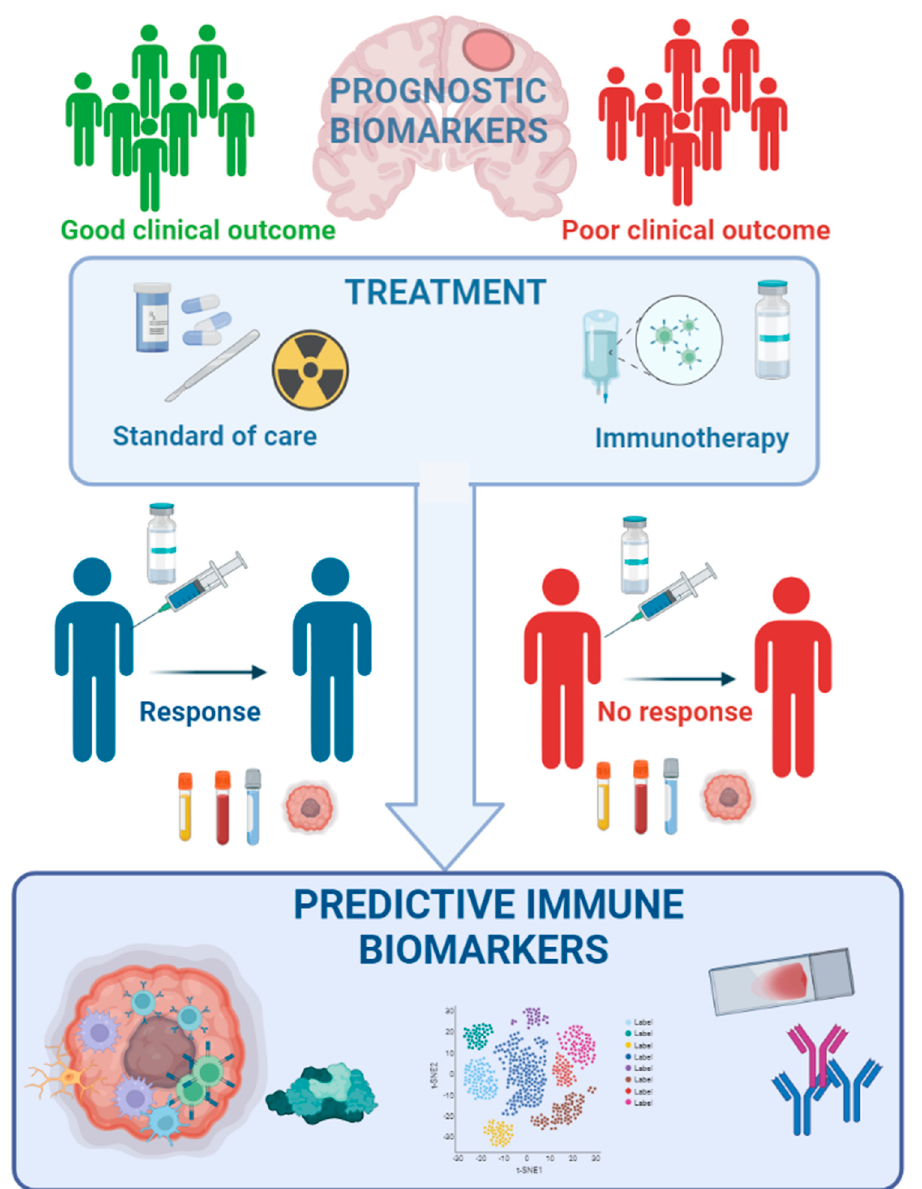
Figure 2. Overview of the prognostic and predictive biomarkers used in GBM patients.